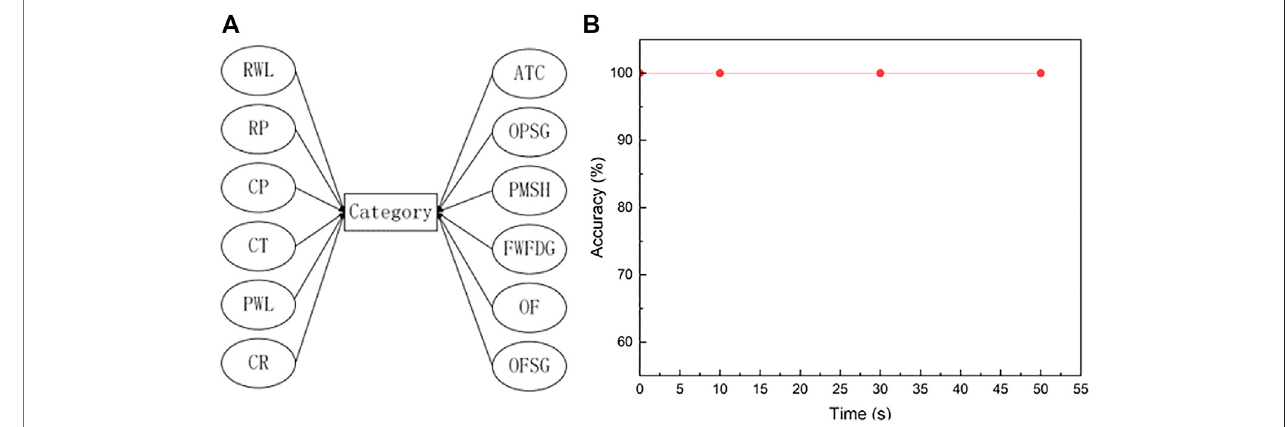
FIGURE 6 | Simpli fi ed Bayesian Network (A) and diagnostic accuracy (B)